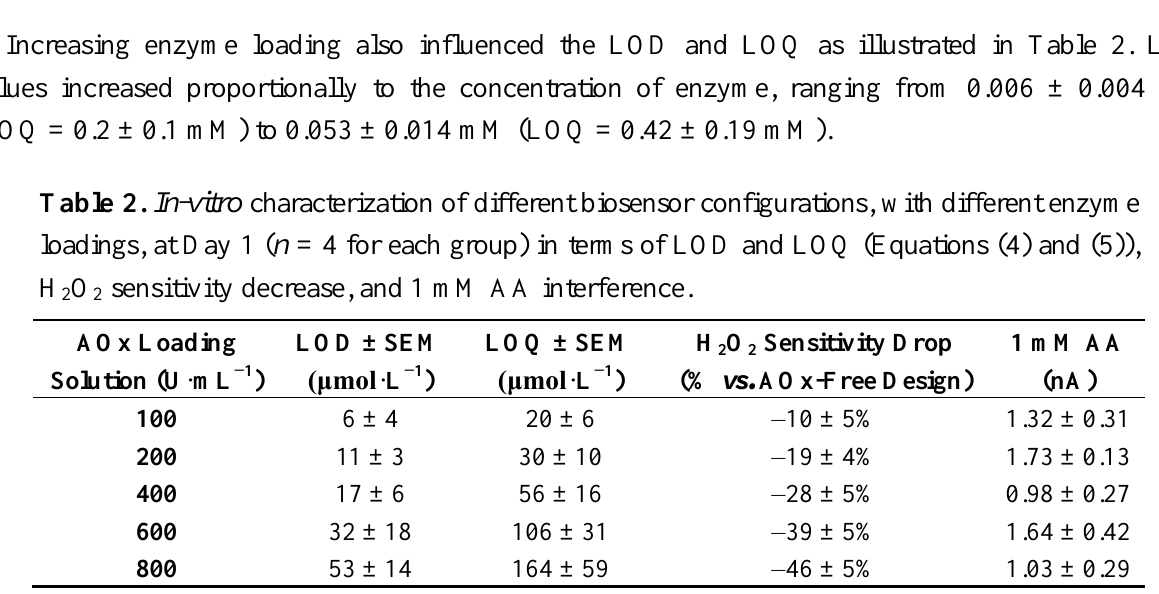
and K ) and linear region slope MAX M